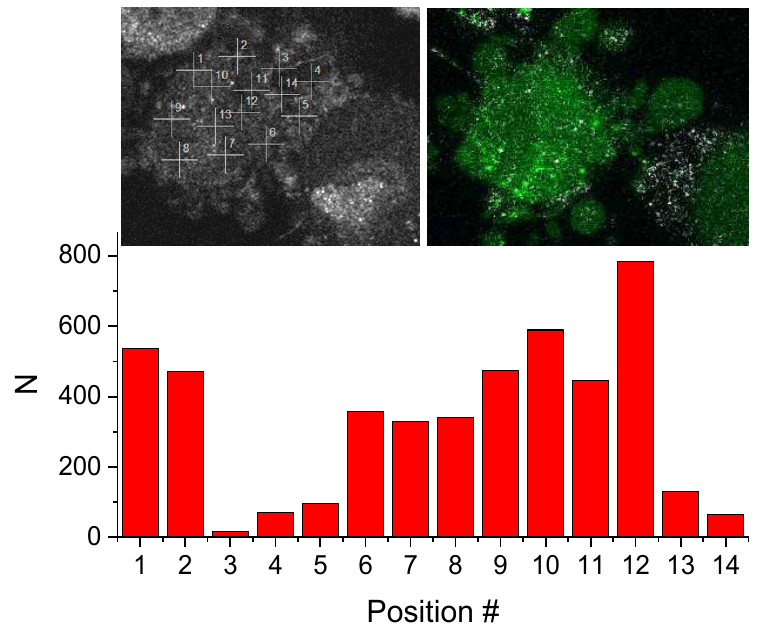
Figure 11. Parameter N values measured in different positions in the HeLa cell. Inset left shows the positions; inset right shows the confocal scan of the cell in the fluorescence mode.